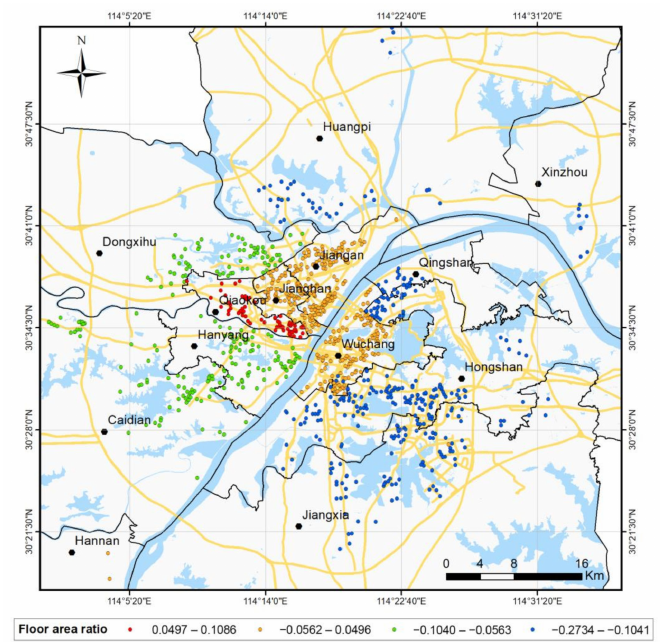
Figure 6. FAR coefficients map of the study